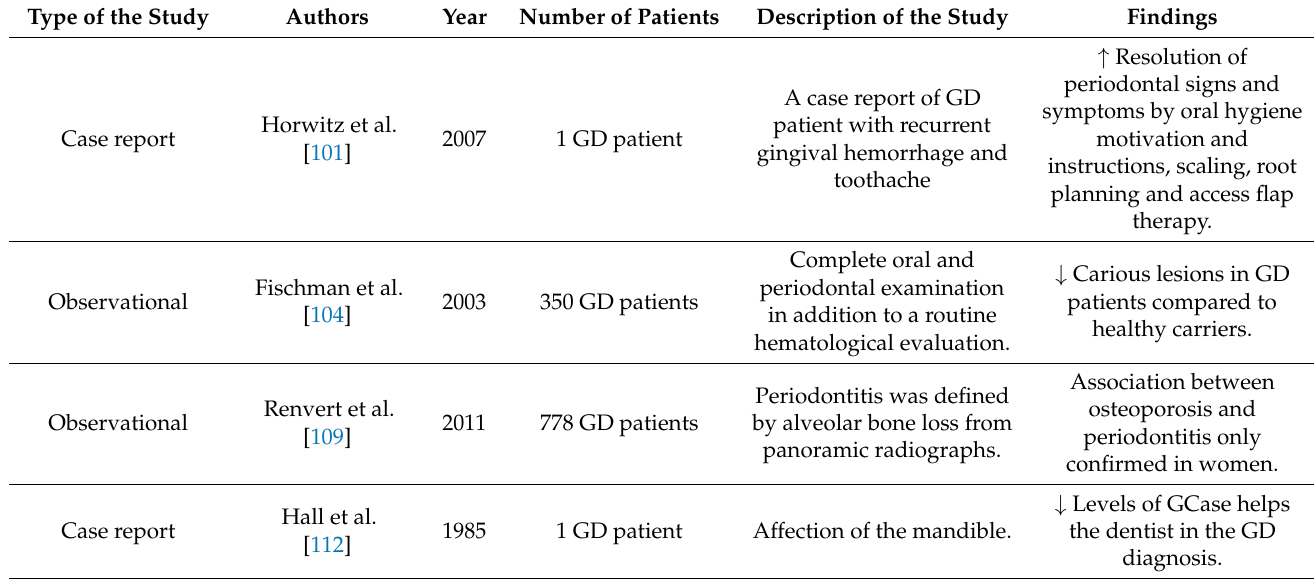
Table 3. GD manifestations and oral